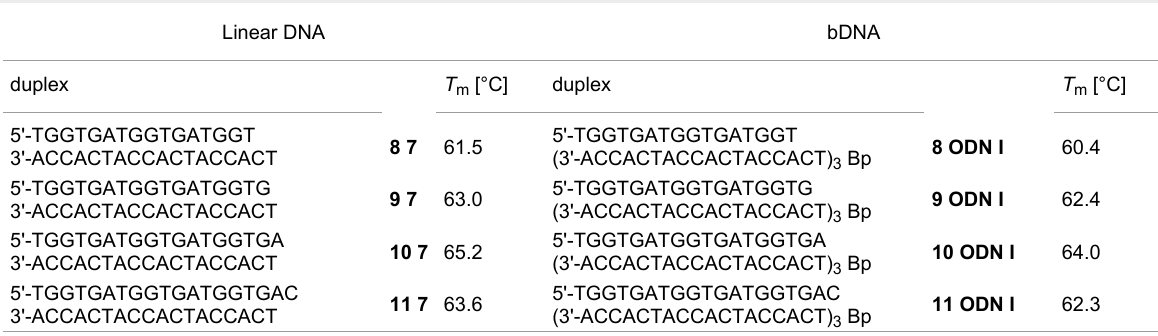
Table 1: Thermal denaturation studies comparing linear and branched oligonucleotides hybridization. Incorporated phosphoramidite 6 is depicted as Bp for branched ODN I . a Linear